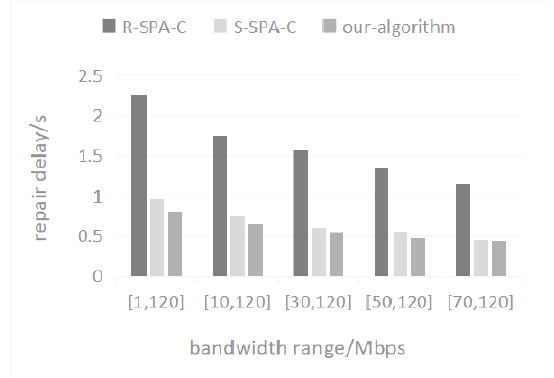
Figure 10. Repair delay distribution of R-SPA-C, S-SPA-C, and our algorithm in different link bandwidth attributes.